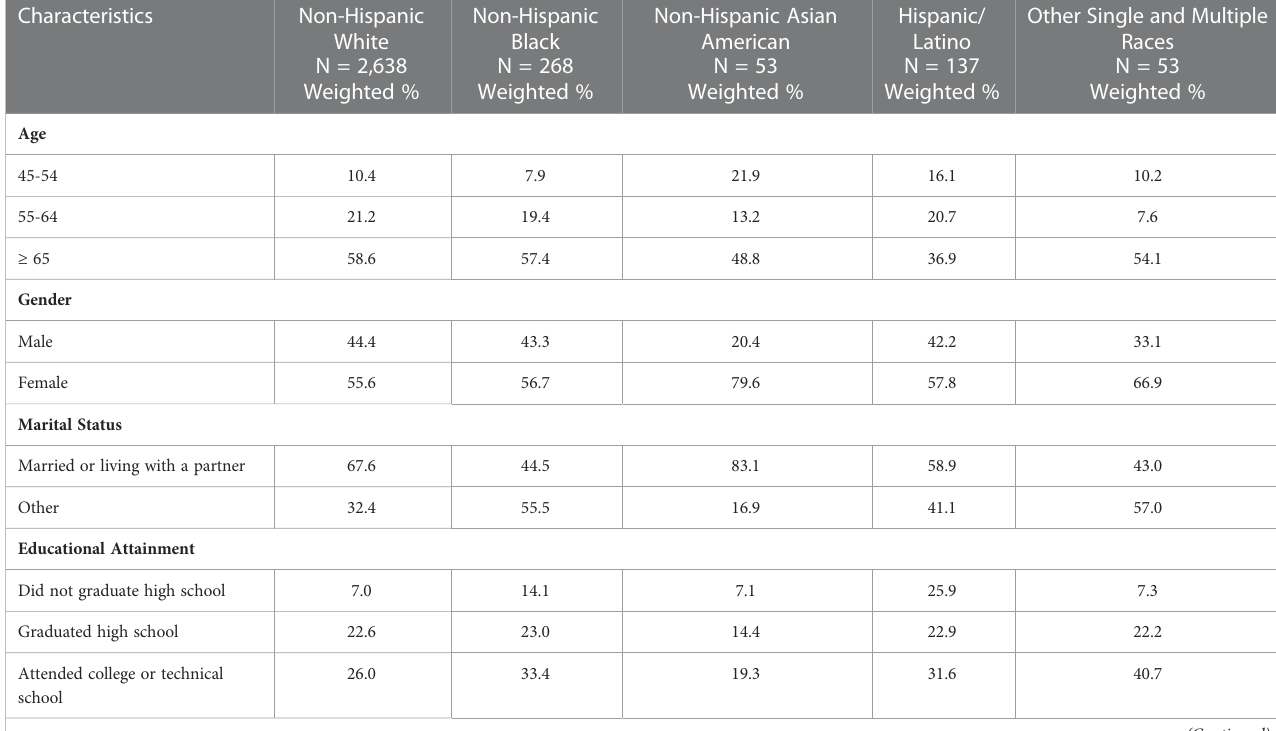
TABLE 1B Cancer Patients without Diabetes Characteristics by Racial and Ethnic Category, NHIS 2021 a,b